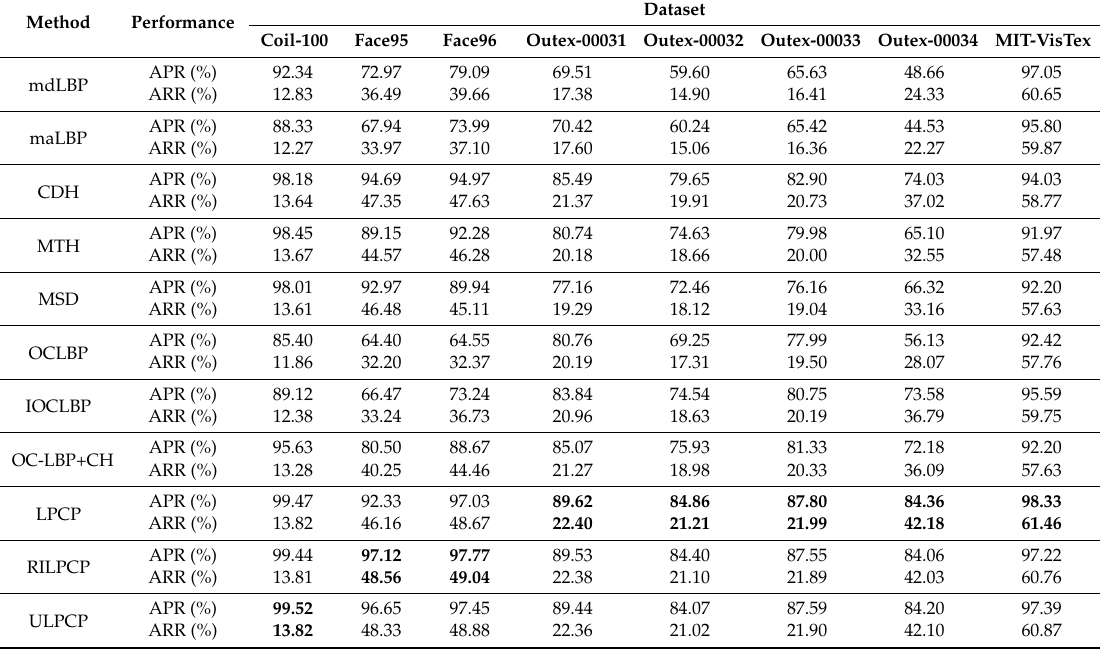
Table 4. The performance comparisons between the proposed descriptors and the existing descriptors in terms of APR and ARR on the eight